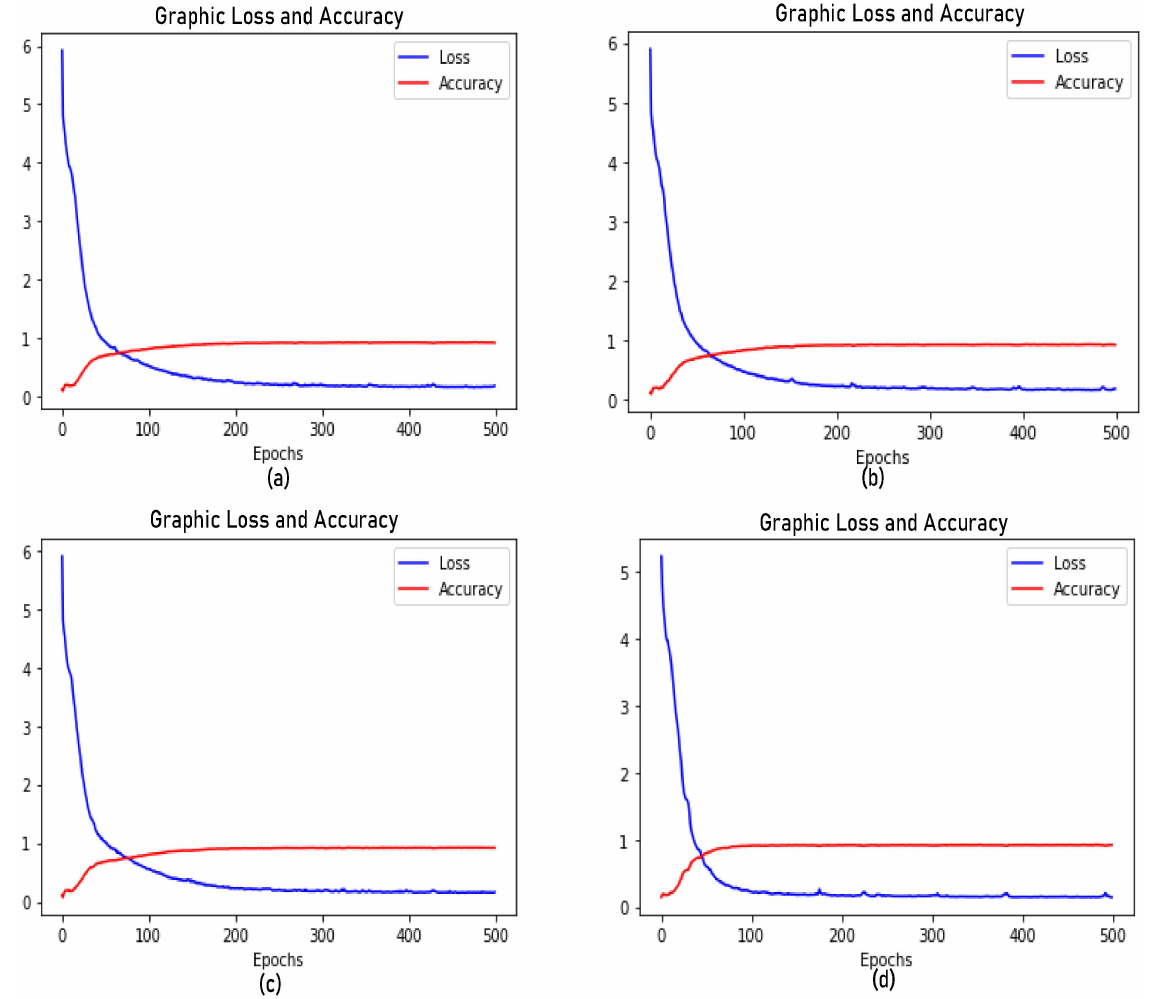
Figure 6. Accuracy and loss graphs of the proposed models: ( a ) CNN-A, ( b ) CNN-B, ( c ) CNN-C, and ( d ) CNN-D. The experiments used 500 epochs as a training measure. The graphs show that each model needed just below 100 epochs to reach its best accuracy.